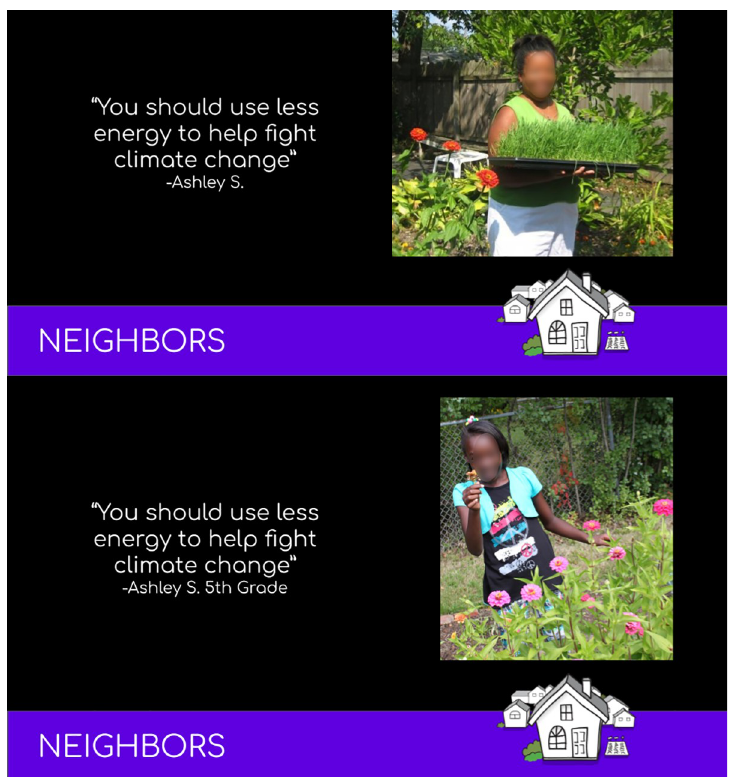
Fig 1. Example of alternative slide content used in different experimental groups. The top panel is one of 16 slides included in the set developed for the experimental condition receiving a combination of injunctive framing of messages attributed to adults. The bottom slide was part of the set delivered to the experimental condition receiving injunctive framing of messages attributed to